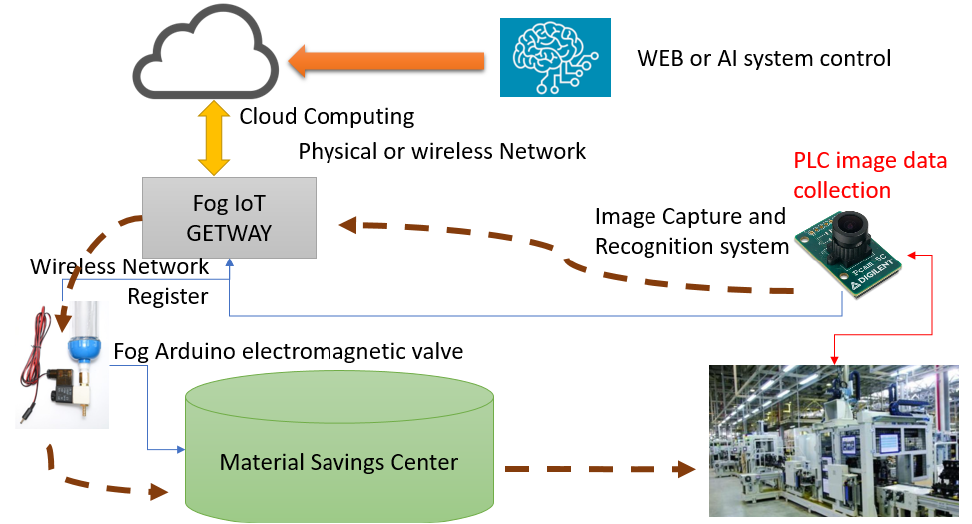
Figure 6. The system architecture.